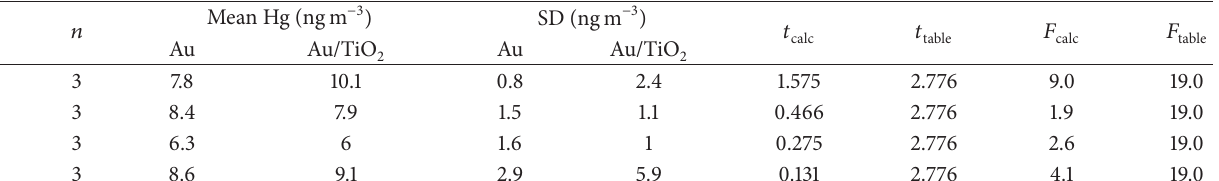
Table 5: Statistical results of TGM measurements ( 𝑡 and 𝐹 were compared at 95% CI).